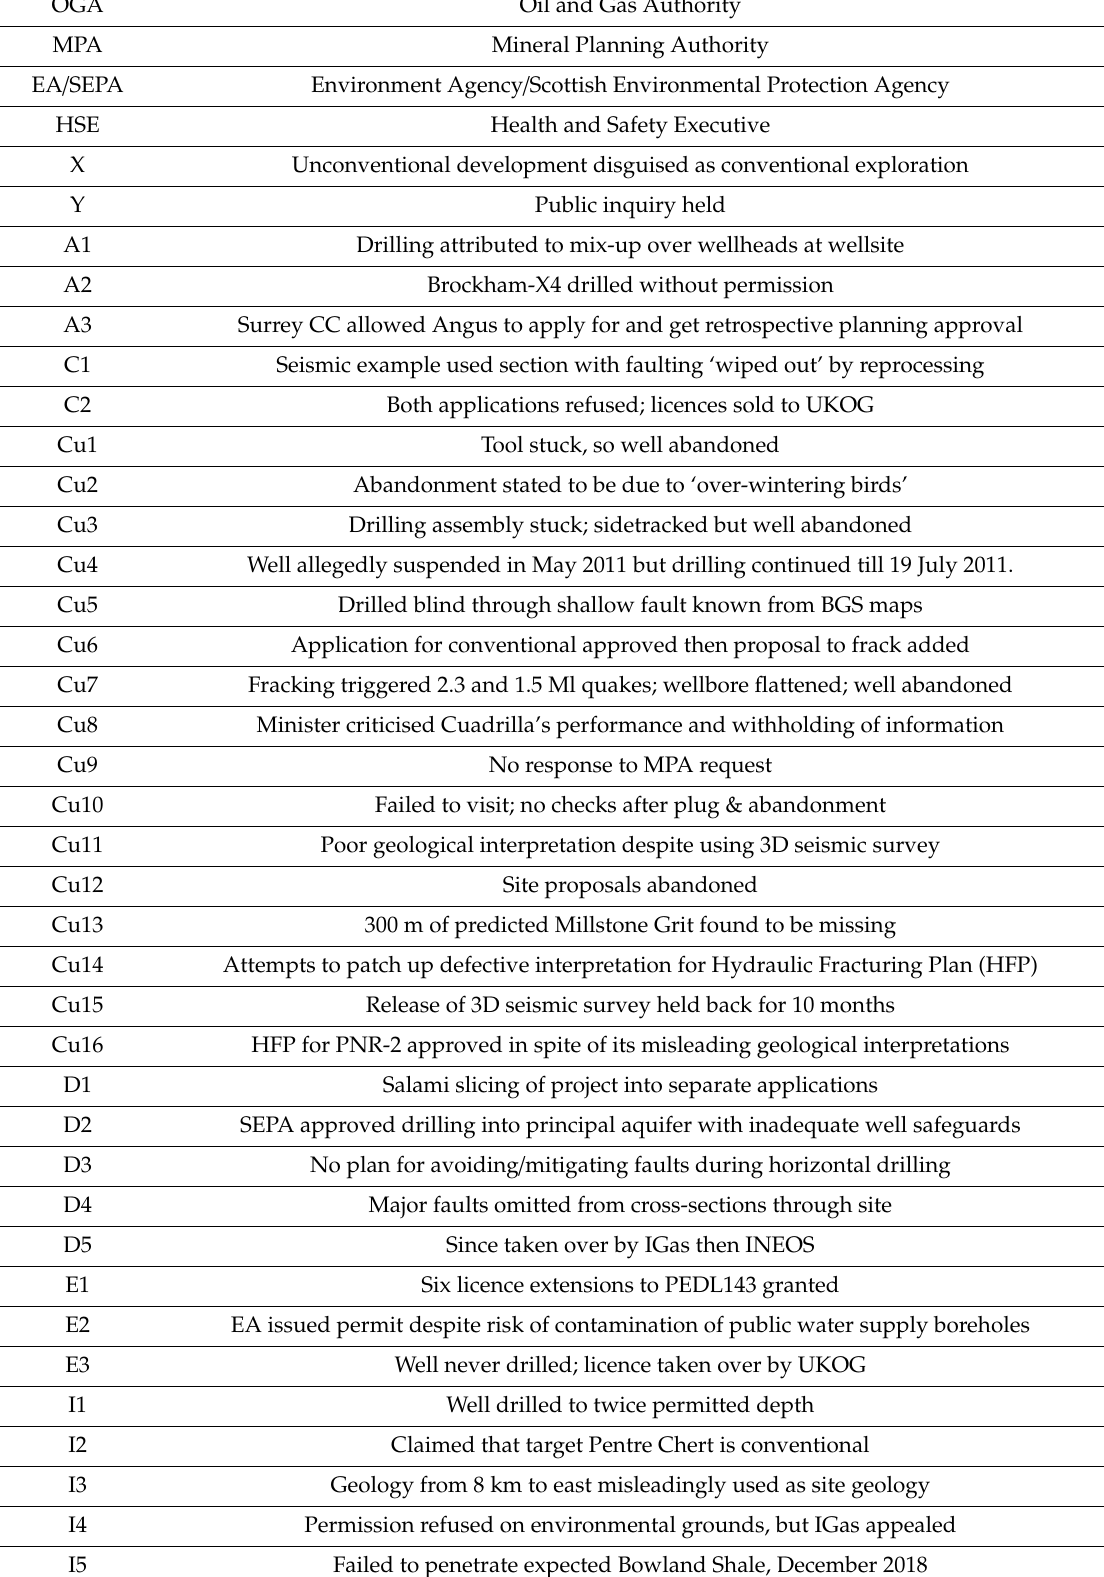
Table 3. Key to Table